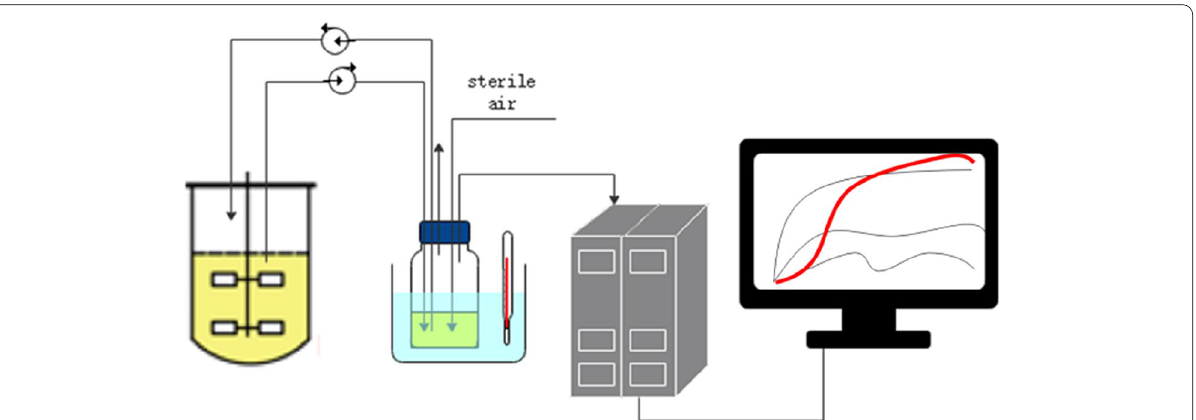
Fig. 1 Schematic diagram of electronic nose detecting system for real-time and on-line monitoring ethanol concentration in fermentation